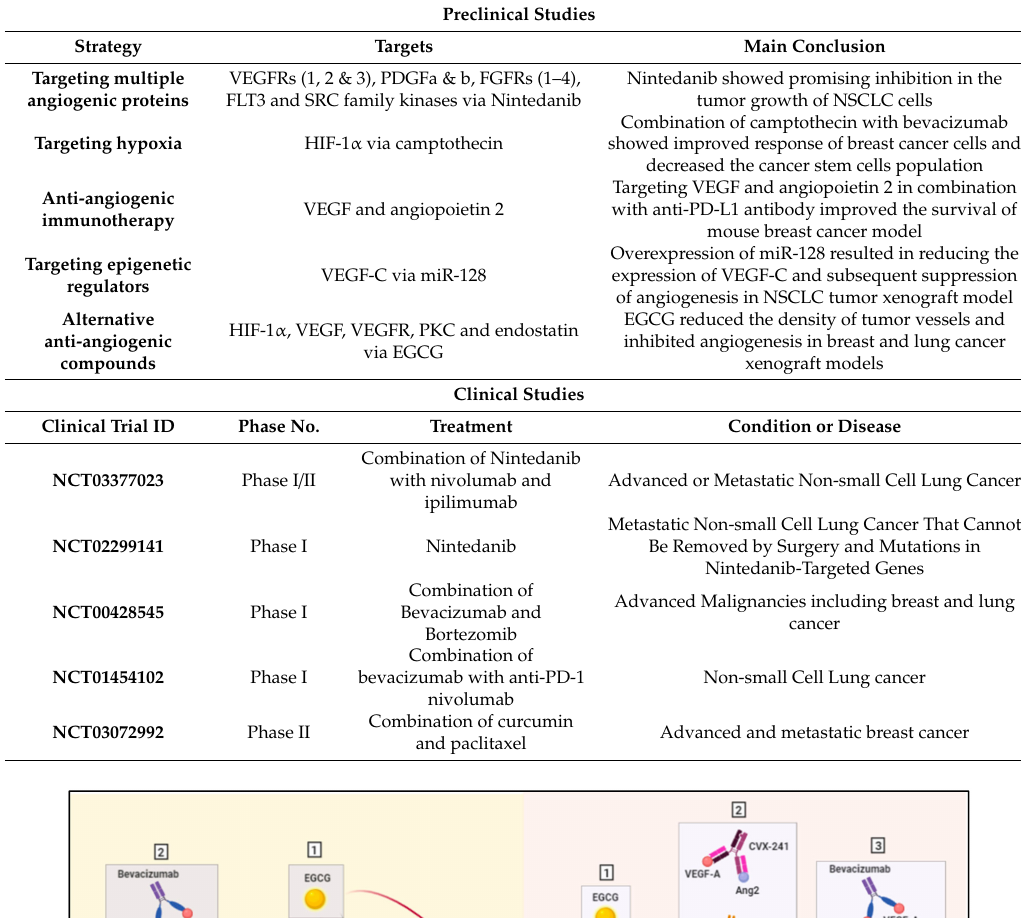
Table 1. Preclinical and clinical studies for overcoming resistance to anti-angiogenic therapies.